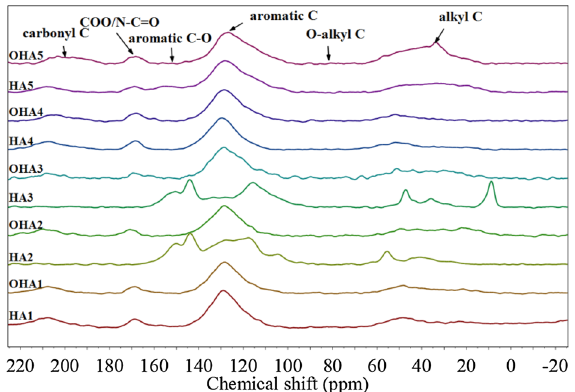
Figure 4. 13 C NMR spectraof HAs. HA1–HA5, the HAs extracted from original coal; OHA1–OHA5, the HAs extracted from oxidized coal.